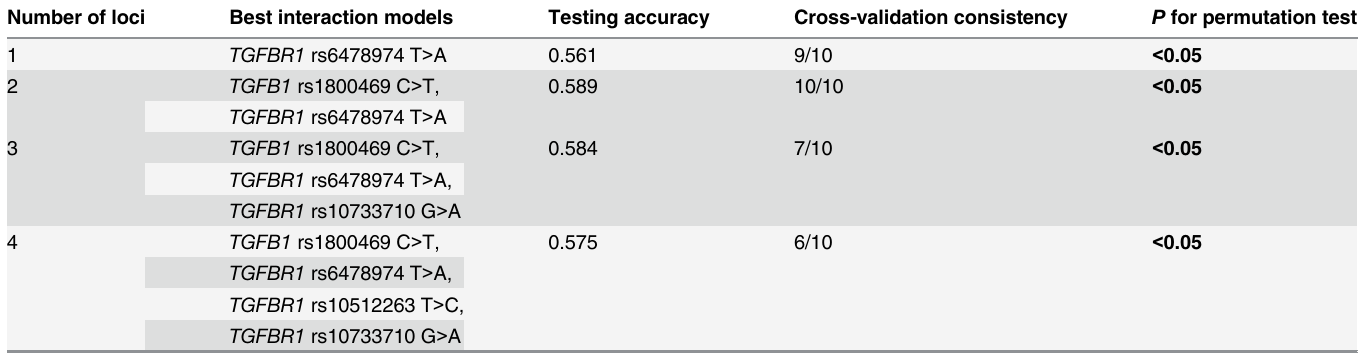
Table 4. Association of high-order gene-gene interactions with EC risk by MDR analysis. Number of